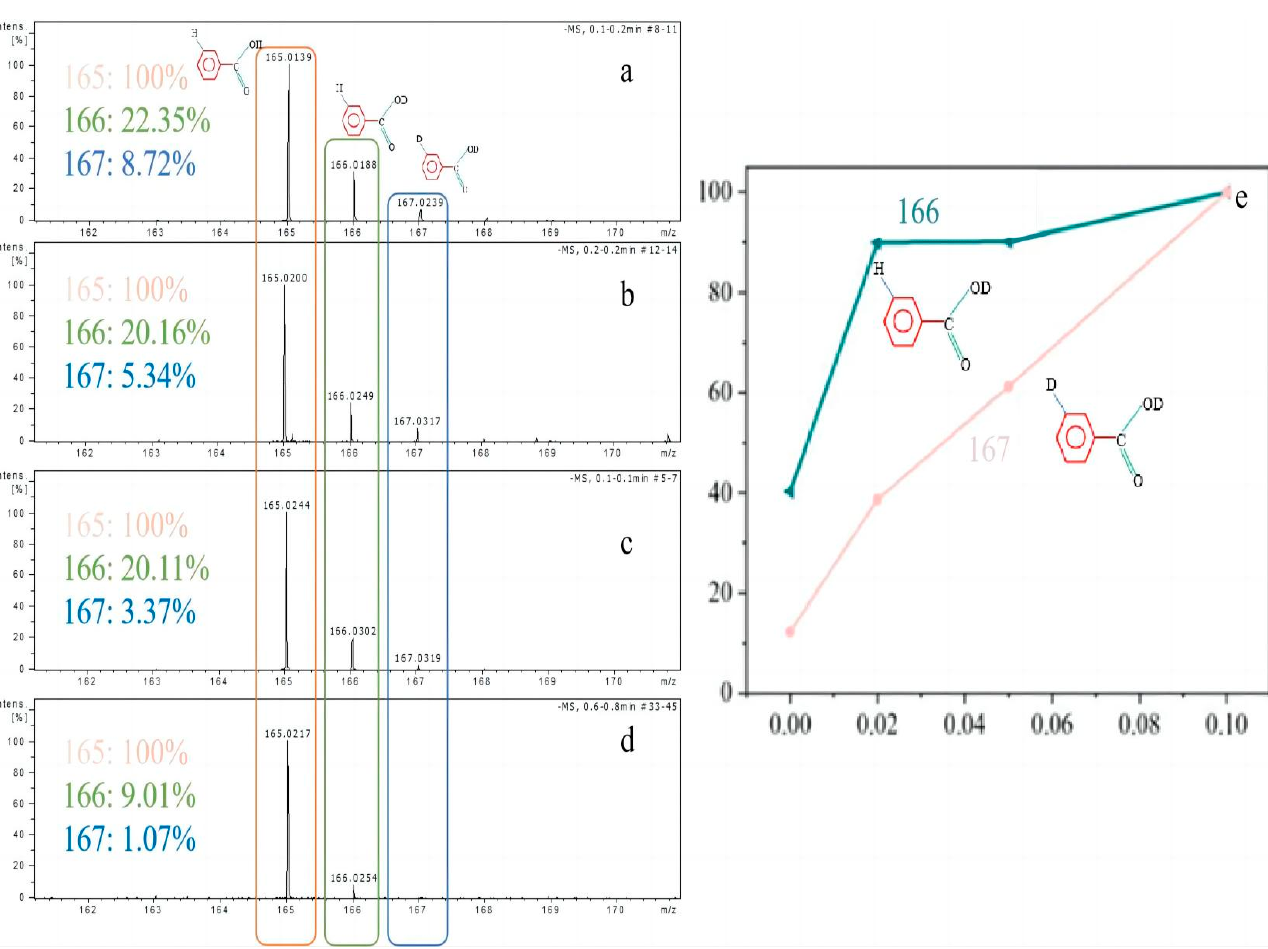
Figure 1. ESI–MS analysis of the solid products. ( a ) Flow rate (D 2 O): 0.1 mL/min; ( b ) flow rate (D2O): 0.05 mL/min; ( c ) flow rate (D 2 O): 0.02 mL/min; ( d ) flow rate (H 2 O): 0.1 mL/min; ( e ) variation of the relative content of molecules with an m/z of 166 and 167 for the di ff erent D 2 O fl ow rates.